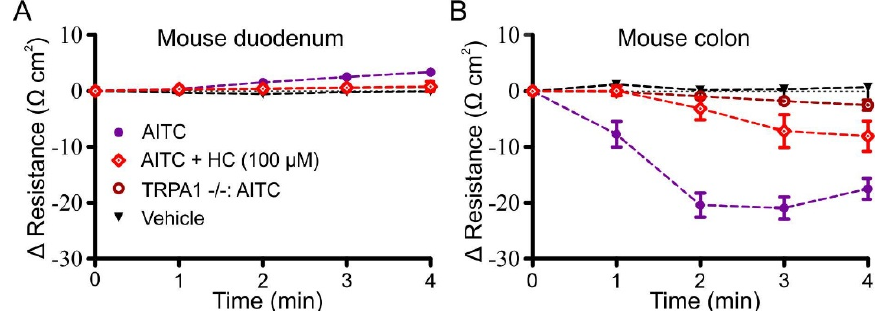
Figure 6. Transmucosal resistance in the first 4 min following the addition of AITC (100 μ M). Comparison of the effect of AITC only, AITC following pre ‐ incubation with HC ‐ 030031 (100 μ M; HC), and AITC in Trpa1 − / − tissues of mouse duodenum ( A ) and distal colon ( B ).